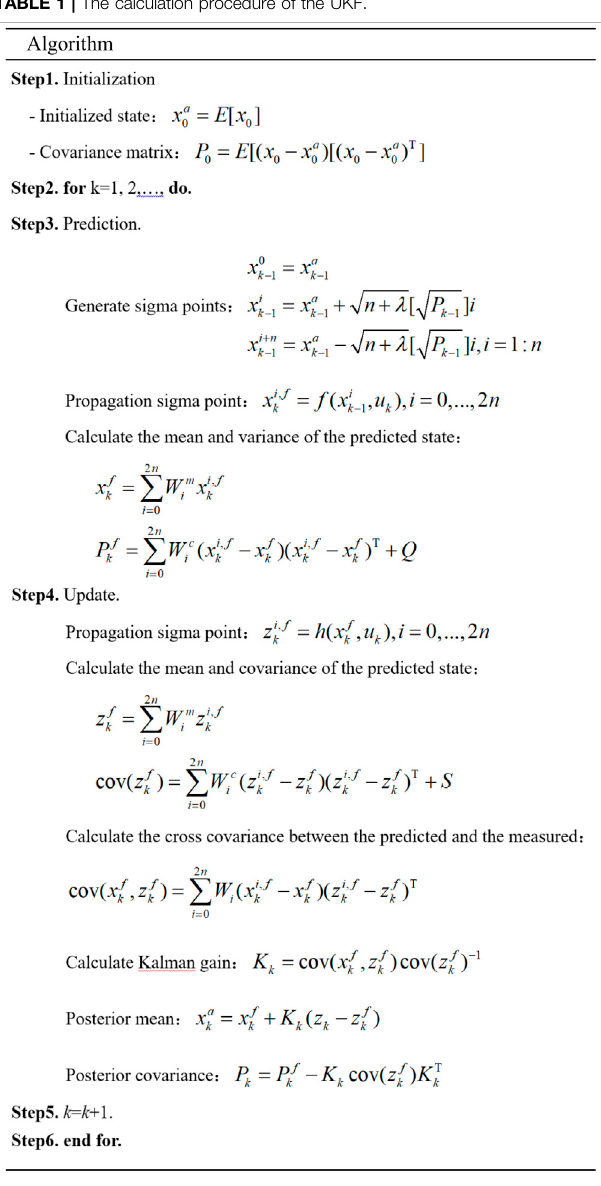
TABLE 1 | The calculation procedure of the